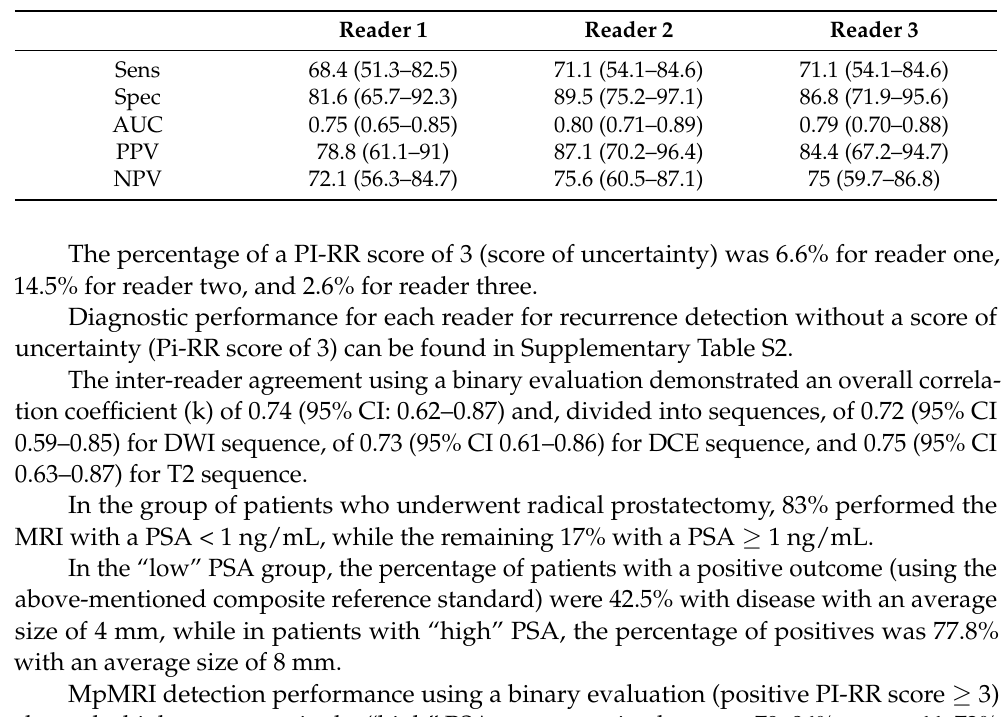
Table 1. Diagnostic performance for each reader for recurrence